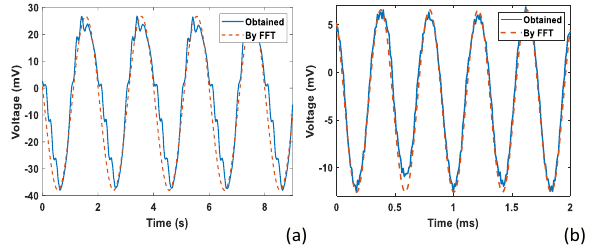
Fig. 6. Data taken for (a) 0.5 Hz and (b) 2.4 kHz